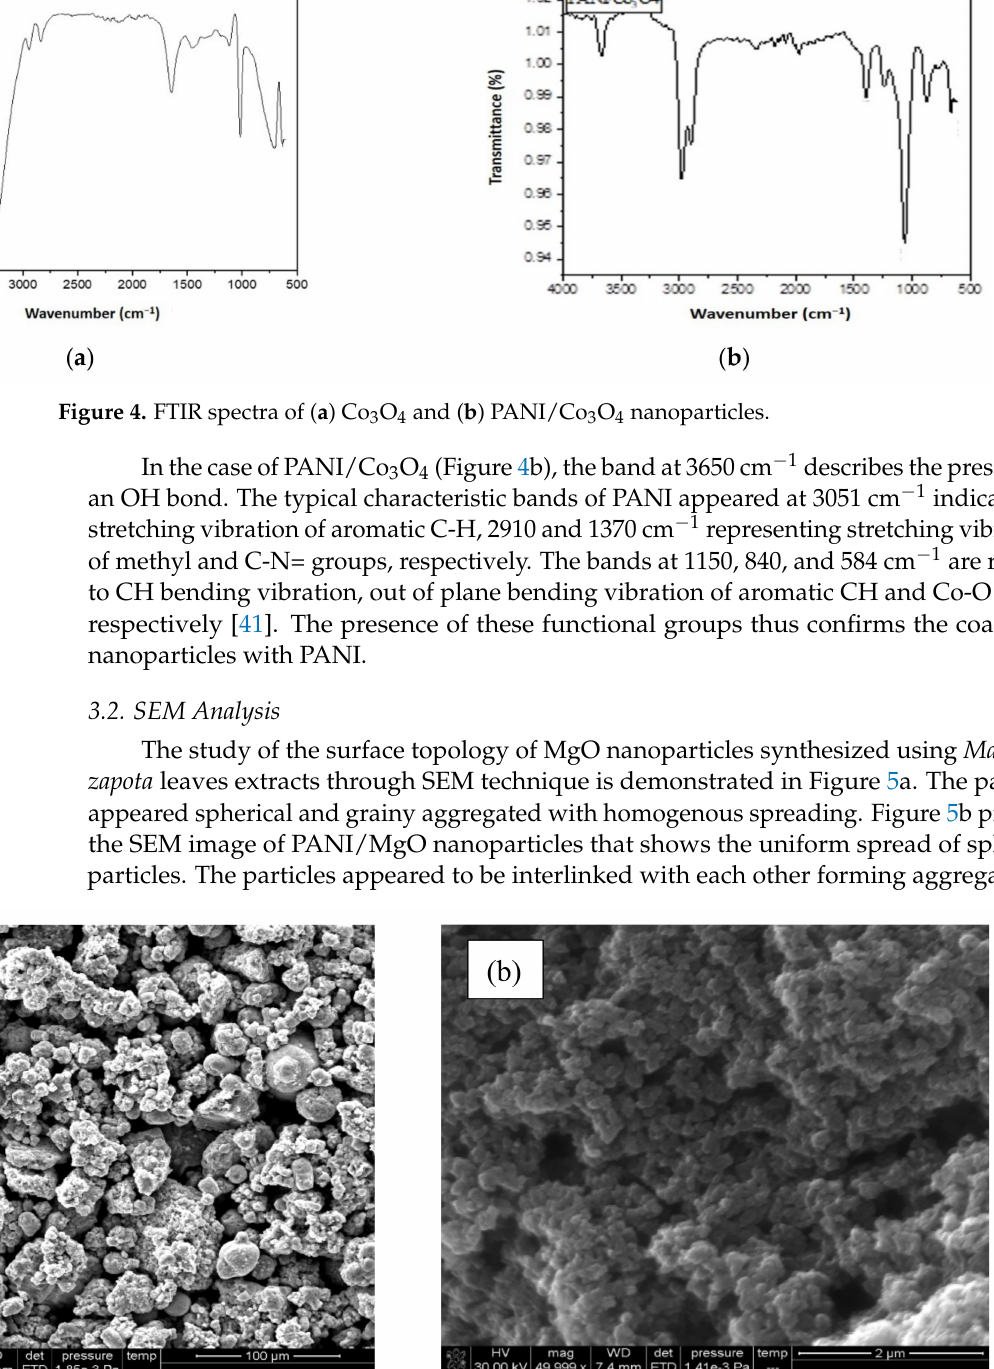
the PANI/Co 3 O 4 nanoparticles have a relatively reduced aggregation whose possible reason might be the presence of a PANI layer around the particles (Figure 6b)